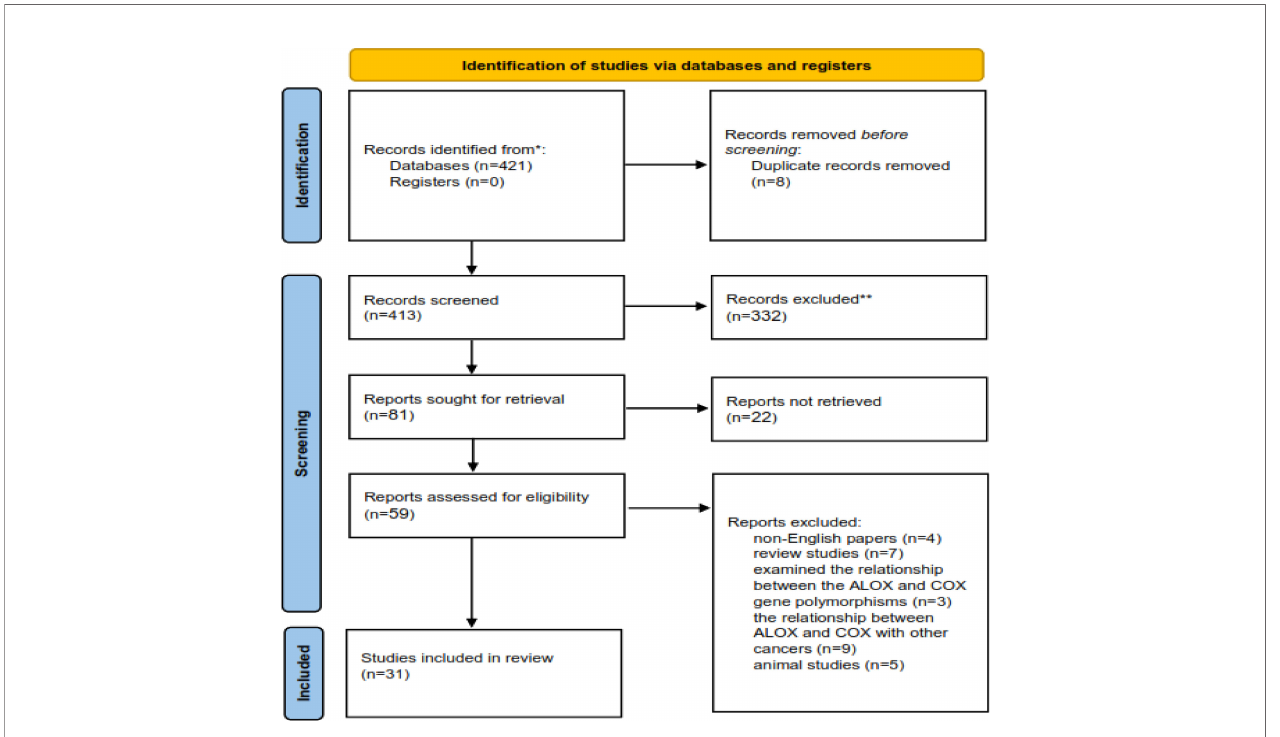
FIGURE 1 | The process of including the appropriate